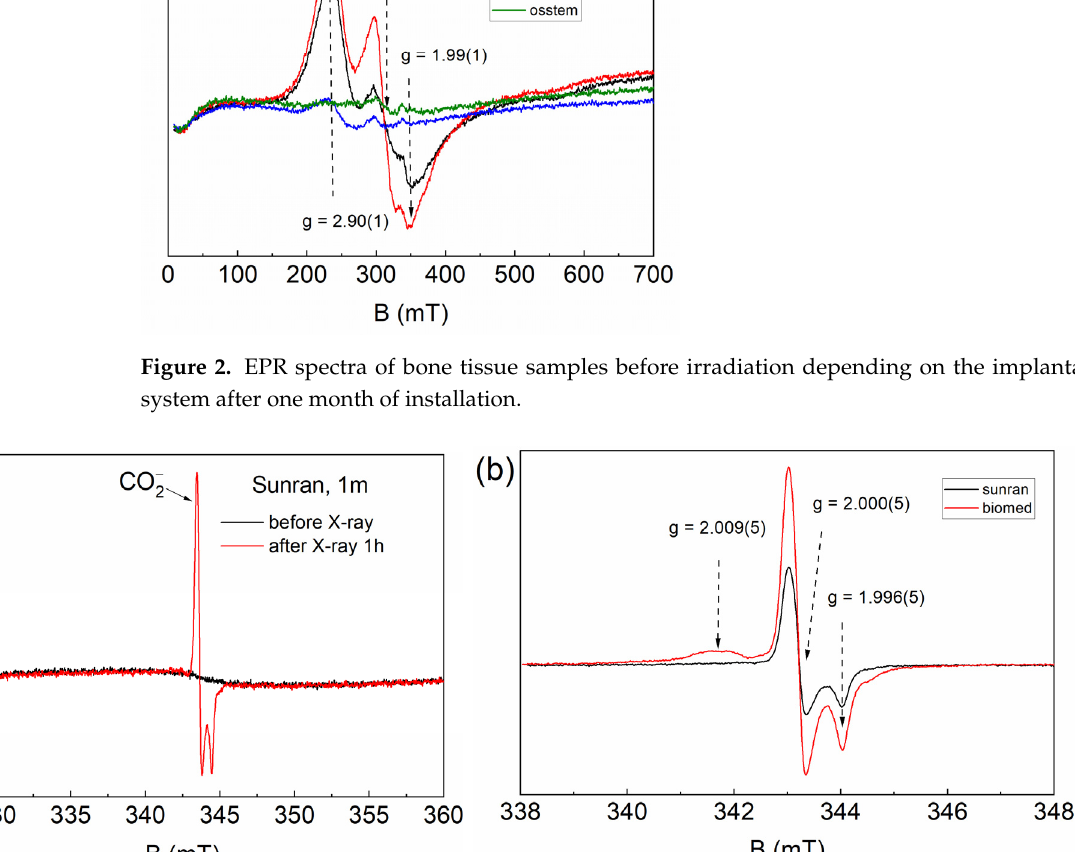
Figure 3. ( a ) Comparison of the EPR lines of the minipig jawbone material after 1 h of irradiation (red) and before irradiation (black). ( b ) The central section of the EPR spectra of bone tissue around the Sunran (black) and Biomed (red) implants after X-ray irradiation.